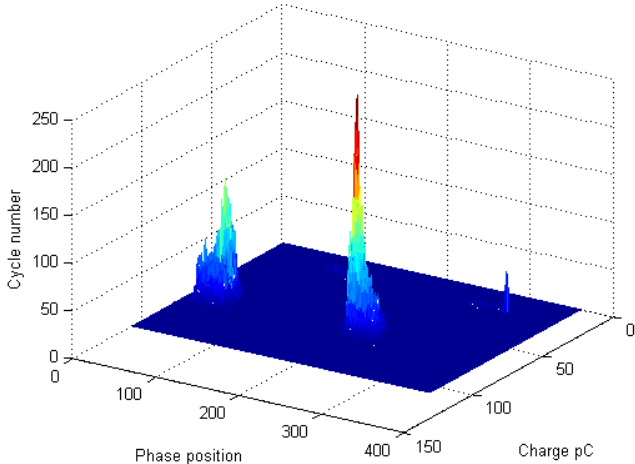
Figure 14. Failure in S-phase cable termination.